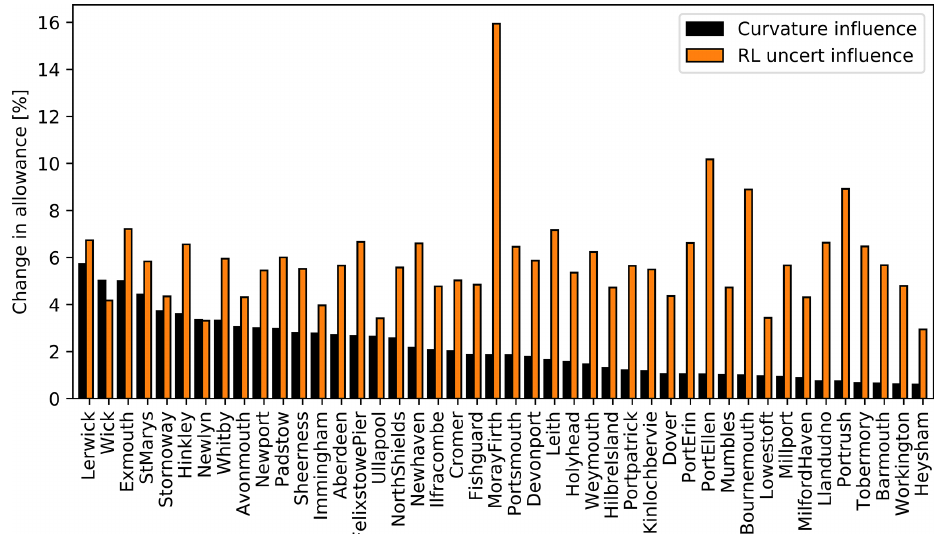
Figure 4. Following Howard and Palmer (2020), we show the sensitivity (black filled bars) of Hunter’s allowance to curvature of the return level plot of still water level (in other words, sensitivity to the departure of the still water extremes from a Gumbel distribution) for 44 sites on the UK coast. Also shown for comparison is the sensitivity to uncertainty in the return level curve. For full details of the method see Howard and Palmer (2020). Sites are ordered by curvature sensitivity (not geographical location).